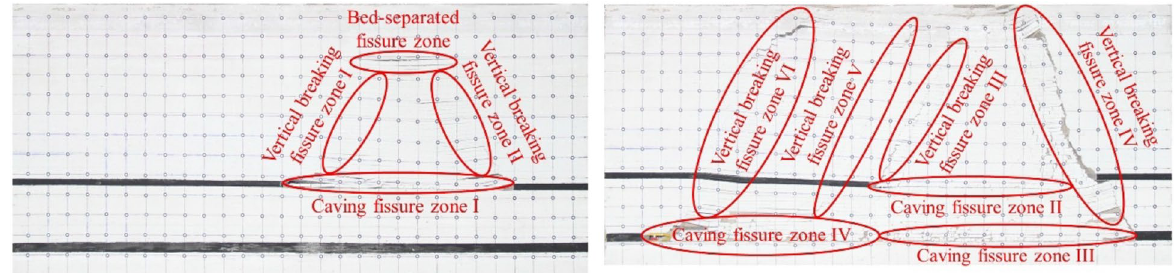
Figure 9. Local fissure zone division.